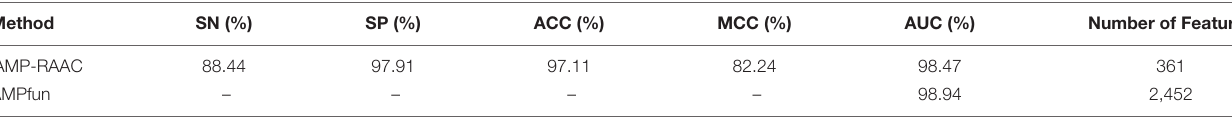
TABLE 4 | Performance comparisons of iAMP-RAAC and the other method on independent test set in DS1.